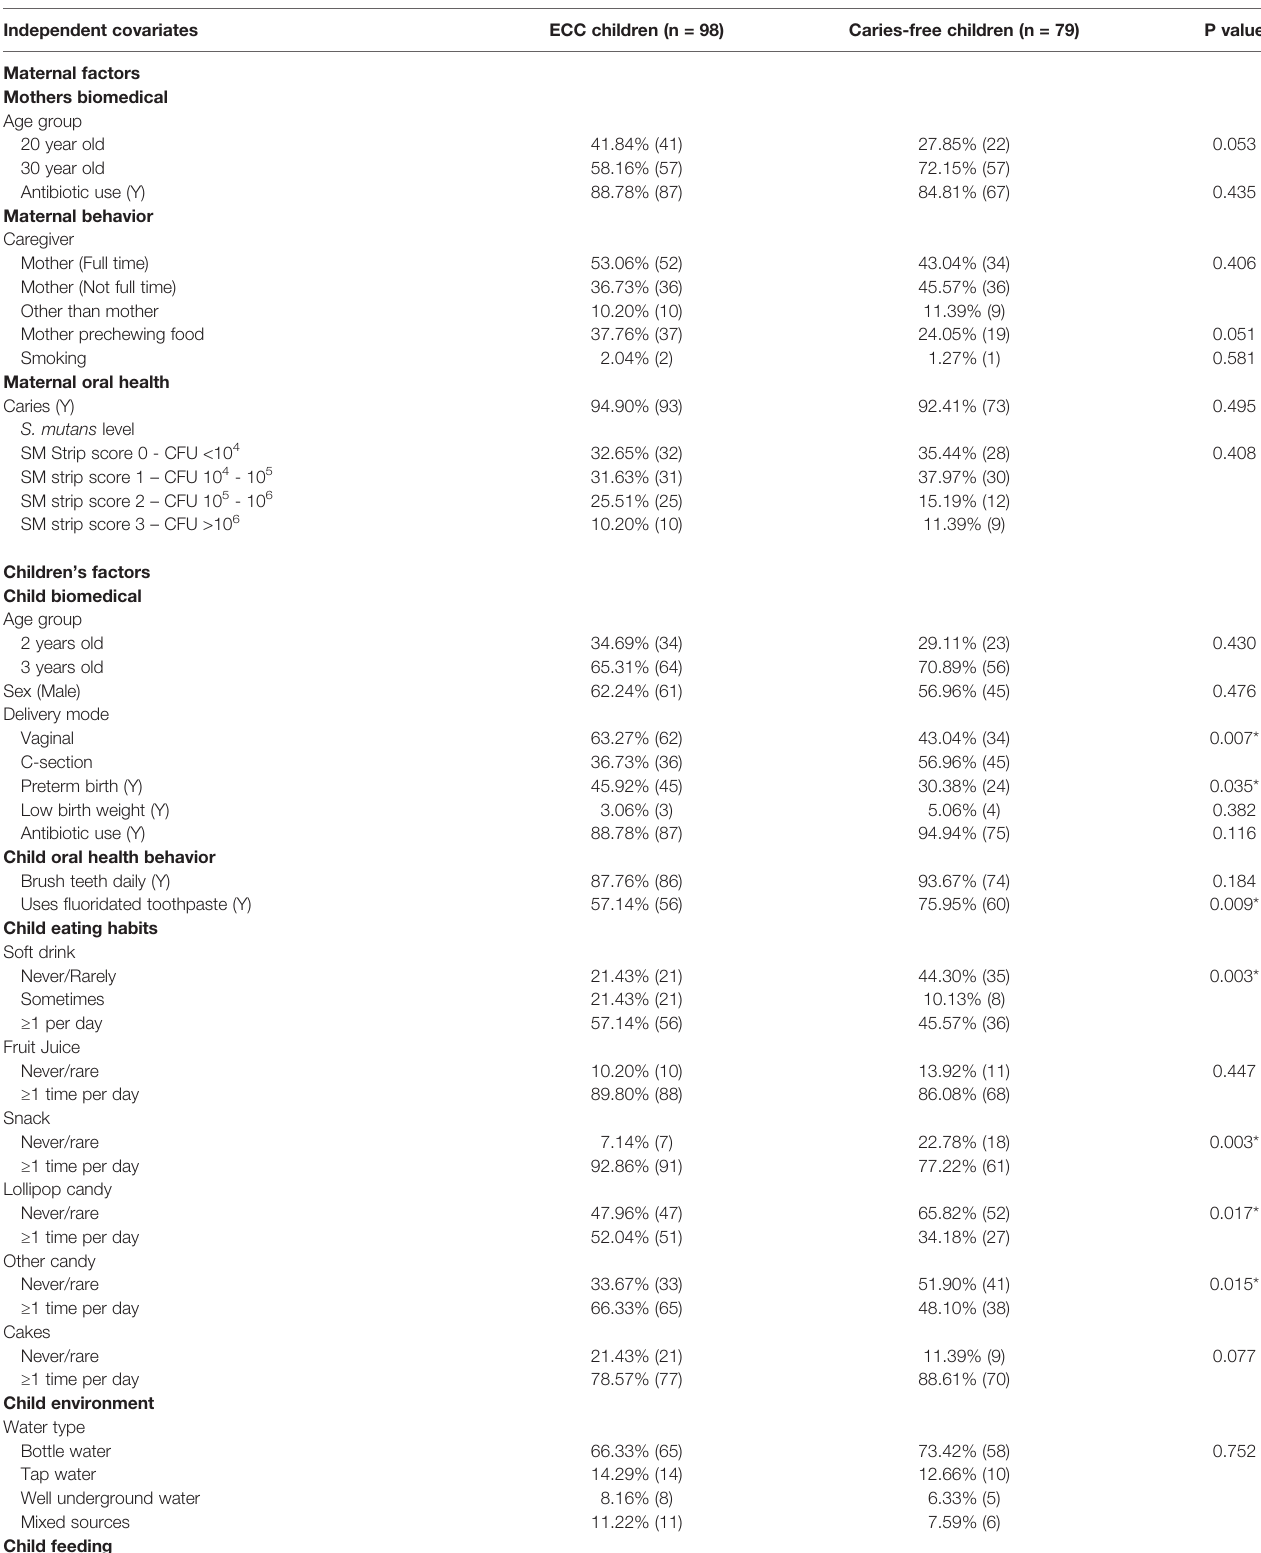
TABLE 1 | Characteristics of Thai children with and without